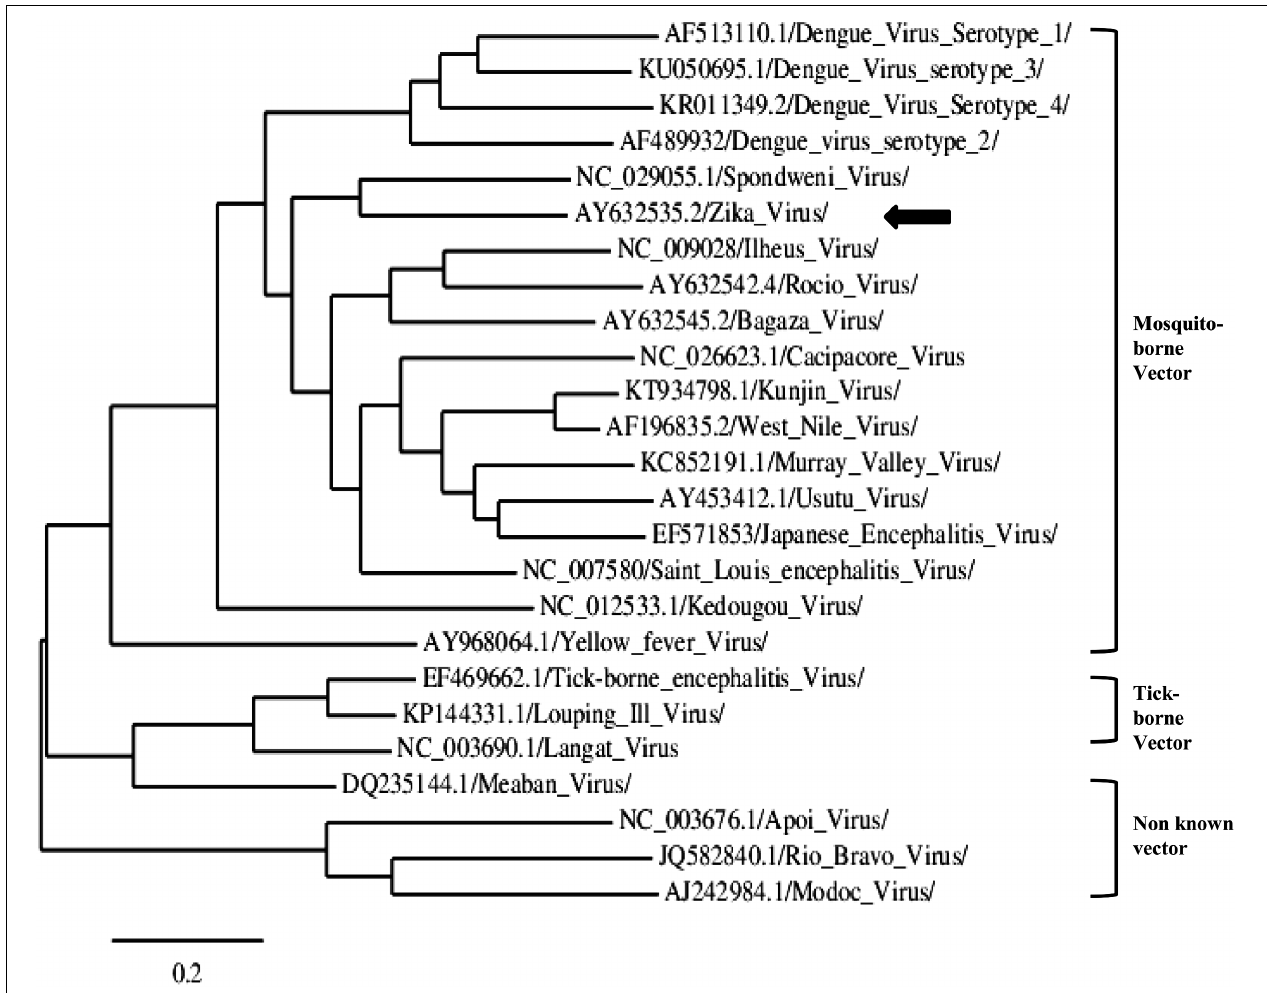
FIGURE 3 | Representative phylogram showing the relationships between strains of the genus Flavivirus. Accession numbers are displayed in the tree. The arrow indicates ZIKV. The scale indicates 0.2 substitutions/site. The tree was based on complete NS5 nucleotide sequence, built from a multiple alignment using Clustal omega and Phylogeny.fr (Dereeper et al.,